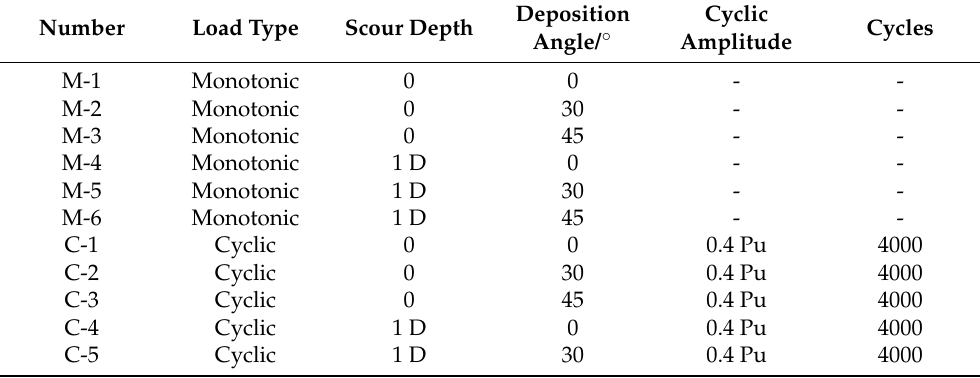
Figure 9. Illustration of the test program. Table 2. Test program.